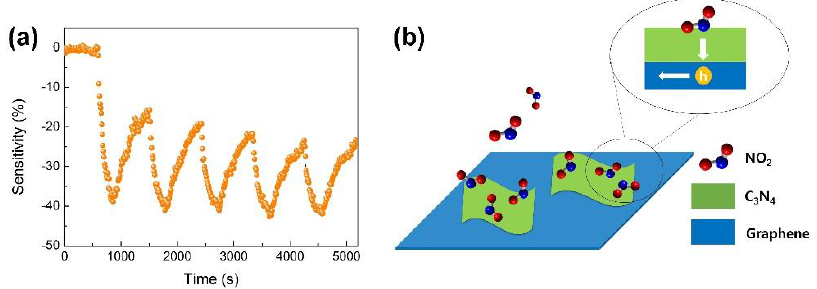
Figure 8. ( a ) Cyclic response of g-C 3 N 4 /graphene composite sensor toward 20 ppm of NO 2 ; ( b ) Proposed sensing mechanism of g-C 3 N 4 /graphene composite sensor.